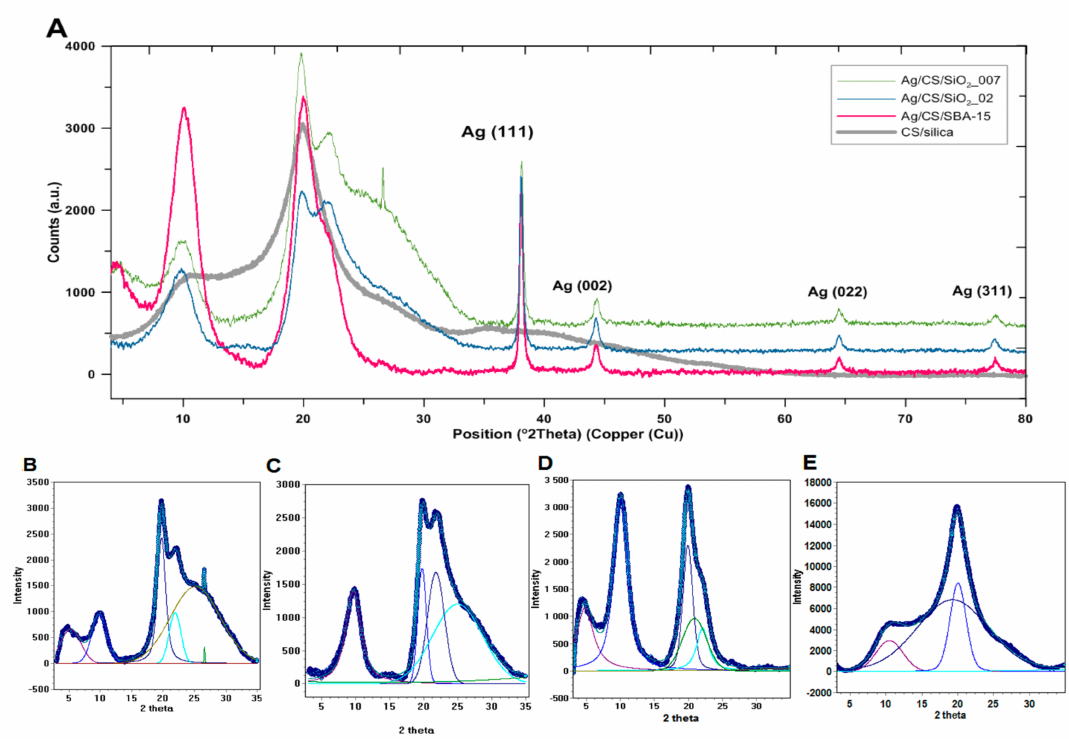
Figure 2. ( A ) X-ray powder di ff raction pattern of the Ag / CS / silica (chitosan nanofibers with silica phase decorated by silver nanoparticles) nanofibers, ( B – E ) Experimental points and fitted profiles of the observed di ff raction patterns (B-Ag / CS / SiO 2 _007, C-Ag / CS / SiO 2 _02, D-Ag / CS / SBA-15, E-CS / silica (CS / SBA-15).